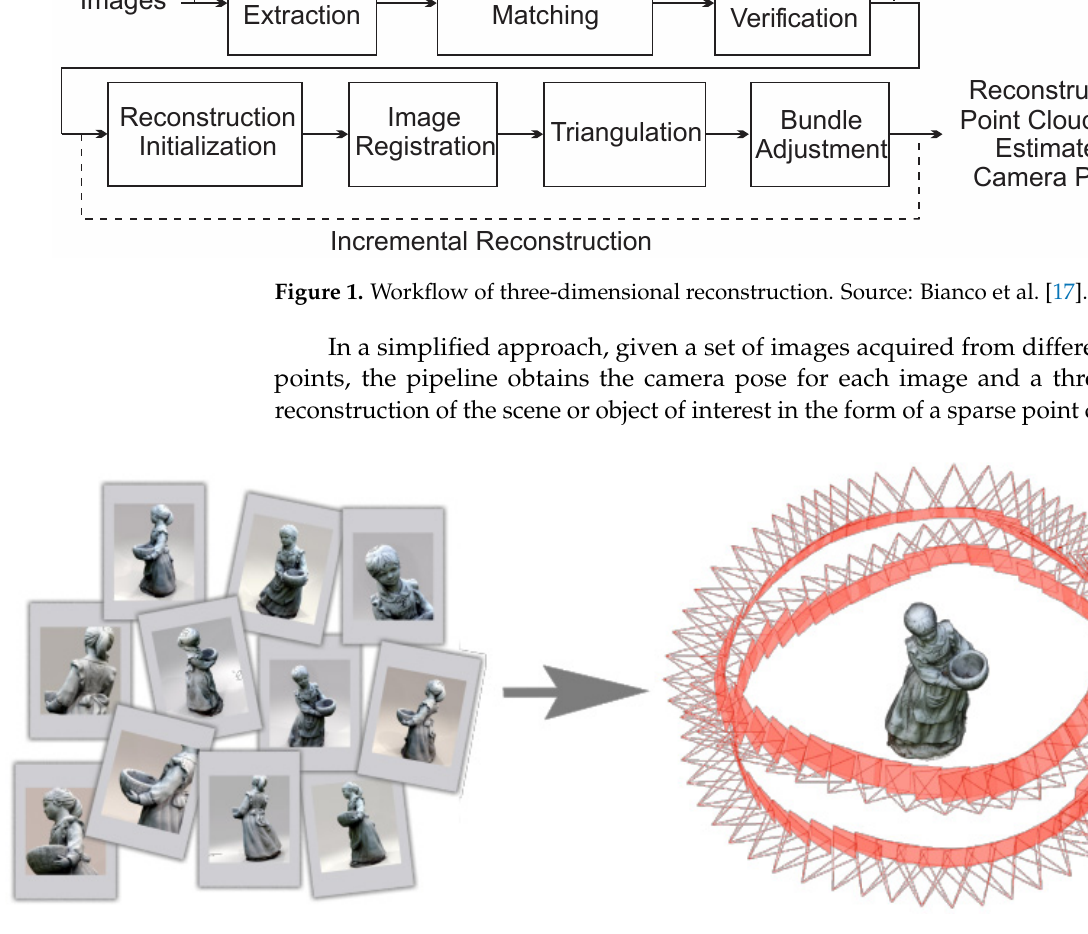
Figure 2. Visual representation of three-dimensional reconstruction. The images on the left are used as base elements in the process in which the camera poses are calculated for each image and the three-dimensional reconstruction through the sparse point cloud. Source: Bianco et al. [17].